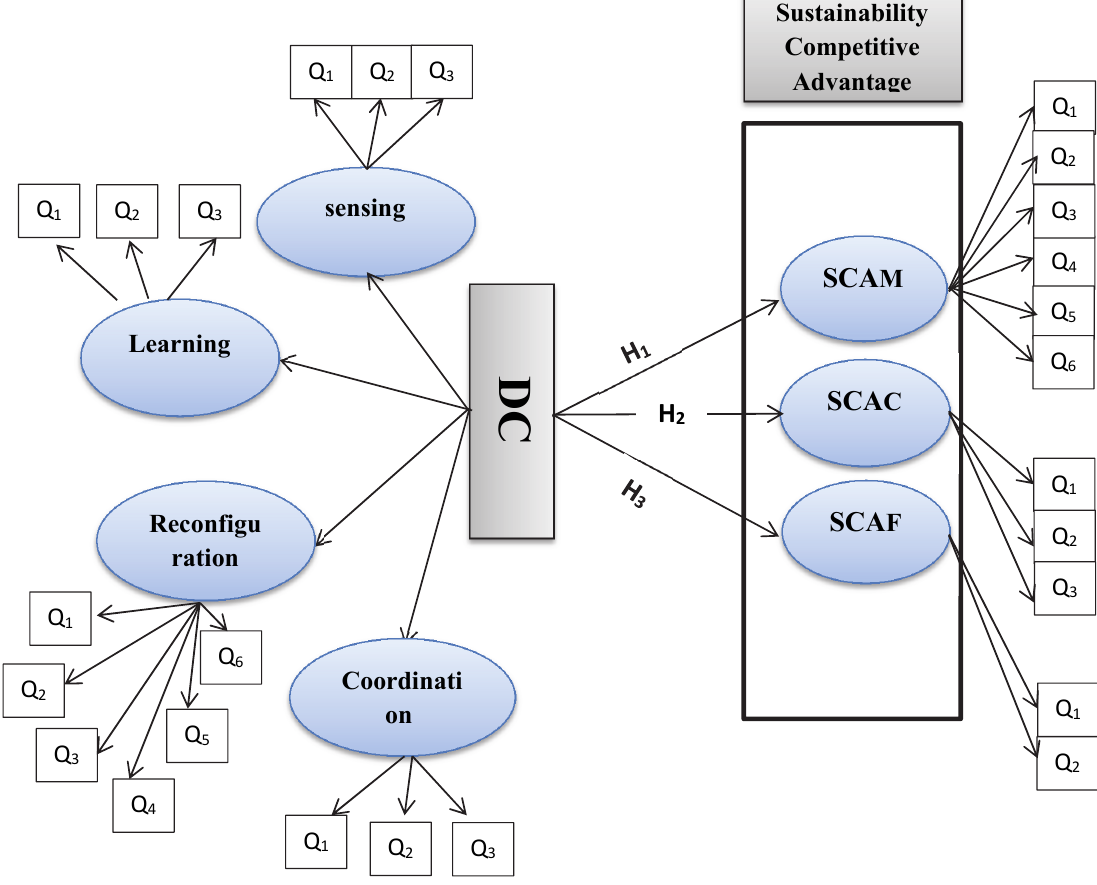
Fig. 1. Conceptual model between DC and